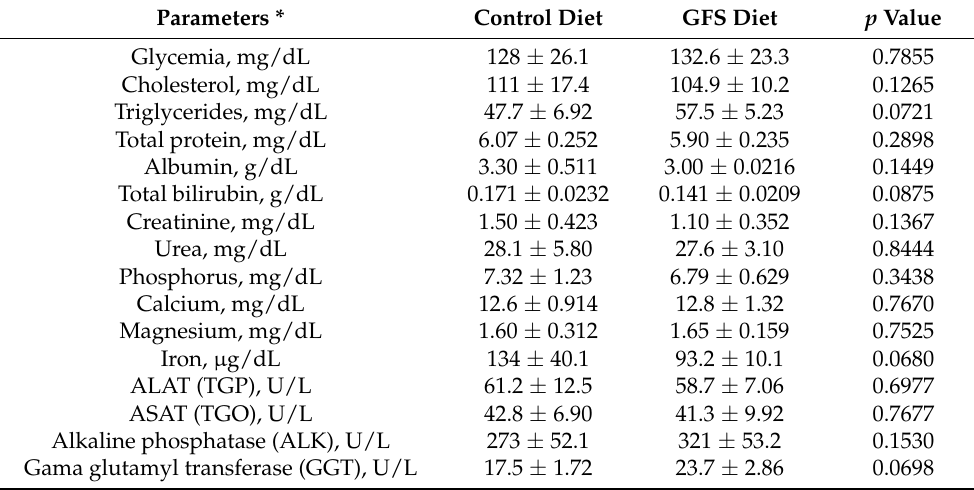
Table 5. The effect of the diets on serum biochemical parameters of weaned piglets. Parameters